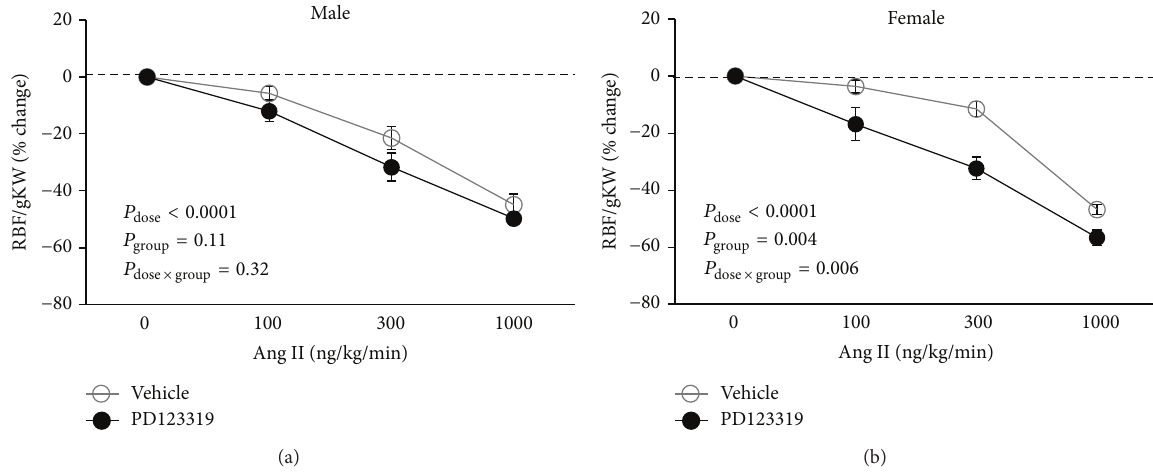
Figure 3: Percentage change of RBF responses to Ang II administration which started to infuse 30 min after reperfusion. Data are shown as mean ± SEM of percentage changes from the baseline (30 min after reperfusion assumed as a base). RBF, renal blood flow. 𝑃 values were derived from repeated measures